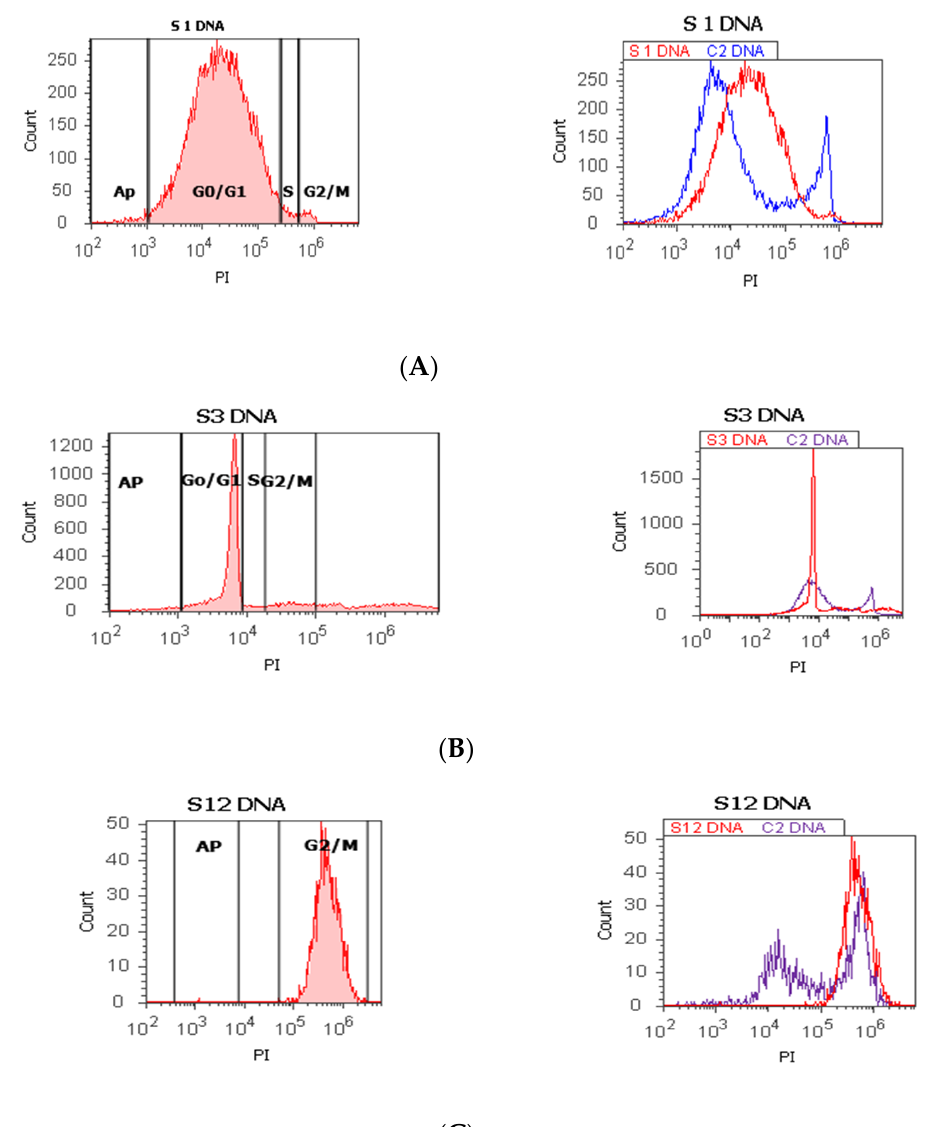
Figure 1. Cell cycle, ploidy, and DNA fragmentation (AP, subG0/G1) represented by propidium iodide stain (PI). Control DNA extrapolate on the PI ax. G0/G1 phase = ( A ) 95.48%; ( B ) 2c 59.44%; 4c 10.87%; 8c 6.52%; 16c 12.68%; ( C ) 0.00%; S phase = ( A ) 1.27%; ( B ) 0.00%; ( C ) 0.00%; G2/M phase = ( A ) 1.13%; ( B ) 0.00%; ( C ) 99.92%; subG0/G1: ( A ) 1.05%; ( B ) 3.31%; ( C ) 0.07%. Legend: AP, cell apoptosis; ( A ) malignant tumor tissue with an invasion of the prostatic urethra (hyperdiploid, cell cycle arrest in G0/G1 phase); ( B ) adenoleiomyoma prostate tissue, chronic inflammation hyperplasia (tetrapoliploidy); ( C ) benign prostatic tissue hyperplasia (aneuploid, present only the G2/M phase). Index of ploidy presented significantly increased values at PCa and BPH cases reported to control cases (PCa 1.38 ± 0.51; BPH 1.19 ± 0.20 vs. C 1.00 ± 0.01, p < 0.01). DNA fragmentation (subG0/G1) had a significantly increased percentage in PCa tissue (4.63 ± 2.69) compared to control tissue samples (1.43 ± 0.11, p < 0.01, Table 1, Figure 1, Appendix A).